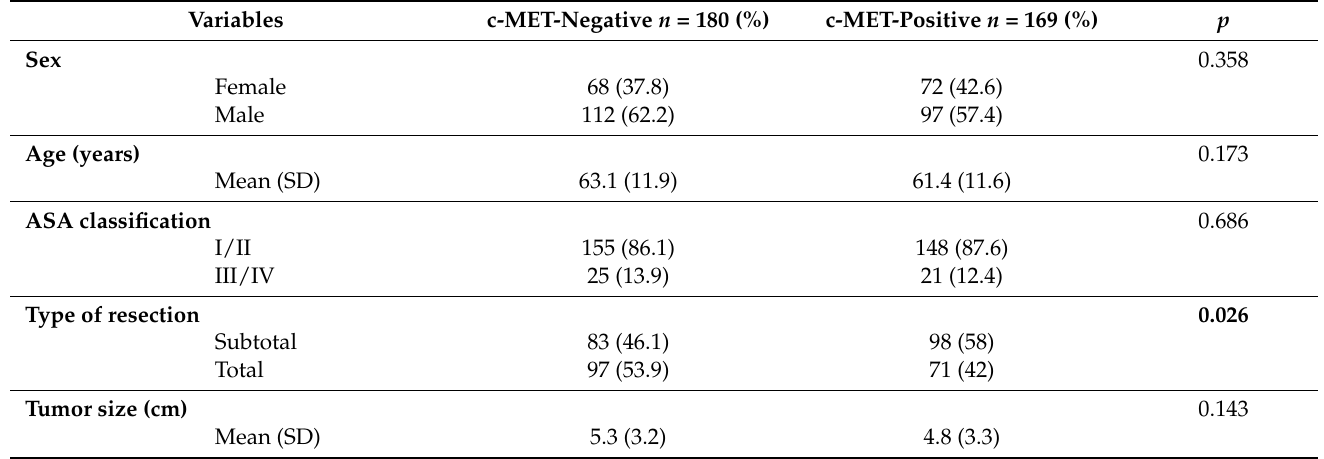
Table 1. Clinicopathological characteristics of gastric cancer patients according to the c-MET